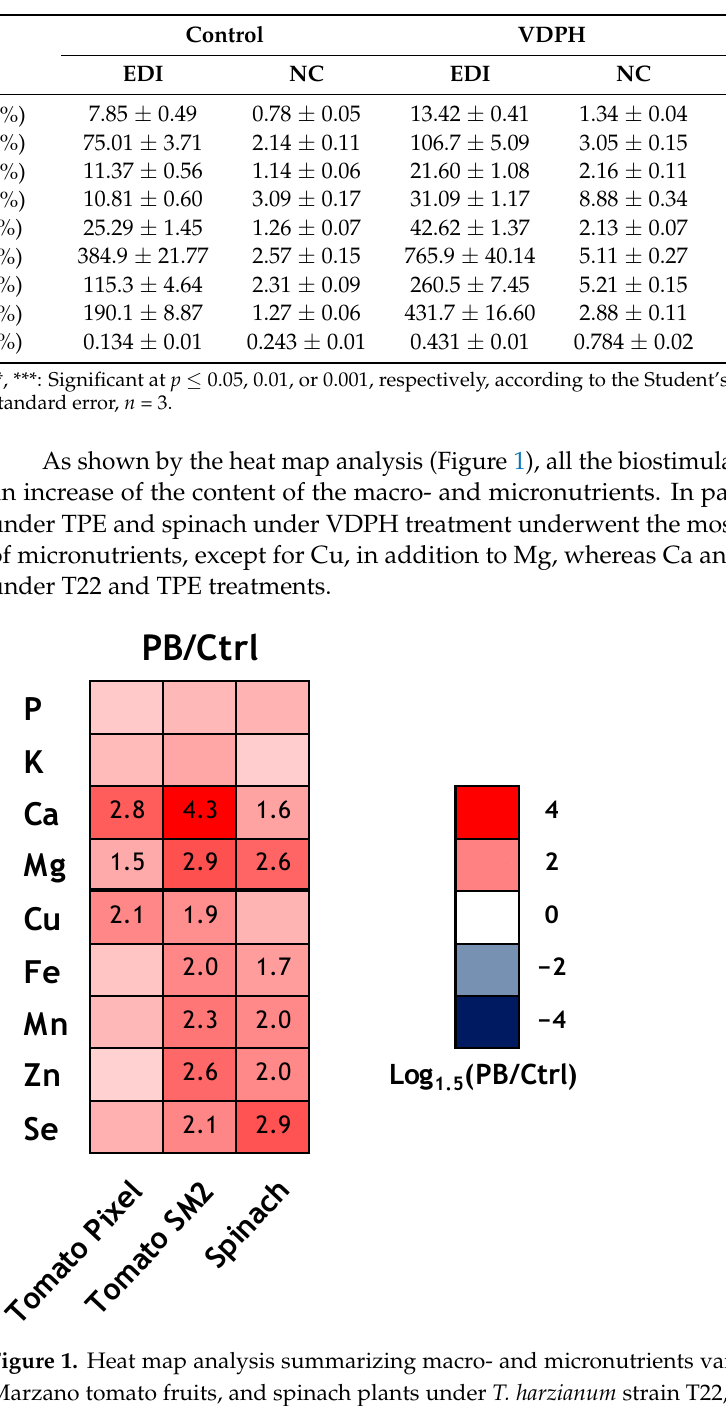
Table 6. Estimated Daily Intake (EDI) and Nutrient Contribution (NC) of spinach plants under control or vegetal-derived protein hydrolysate (VDPH) treatments.